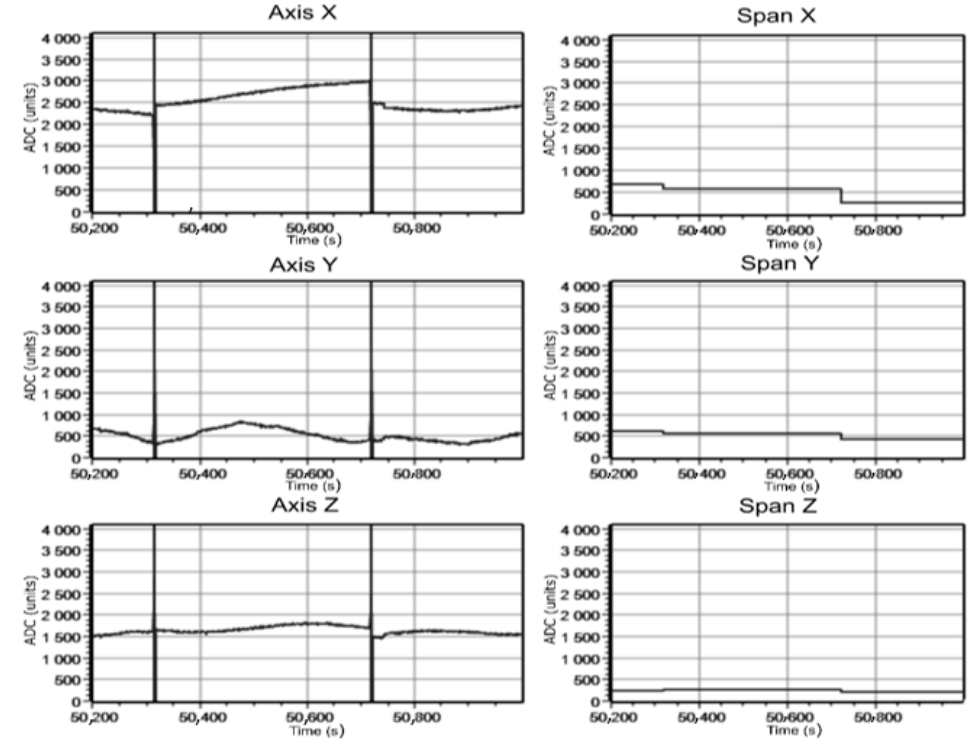
Figure 16. Signals with no current in the cable.